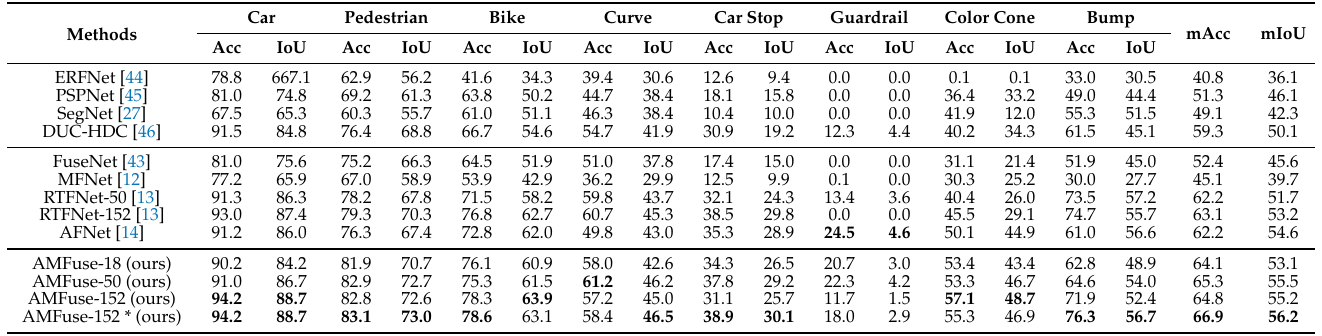
Table 1. The comparisons to the state-of-the-art methods (%). Our proposed AMFuse methods and RTFNet method are with different ResNet backbone encoders, such as ResNet-18, ResNet-50 and ResNet-152.